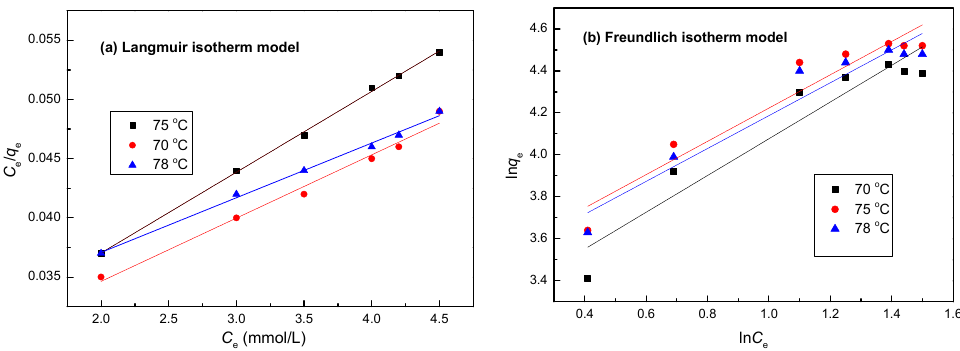
Figure 12. Adsorption isotherms of Co(II) onto LMT nanocomposite at different temperatures: ( a ) Langmuir; and ( b ) Freundlich.